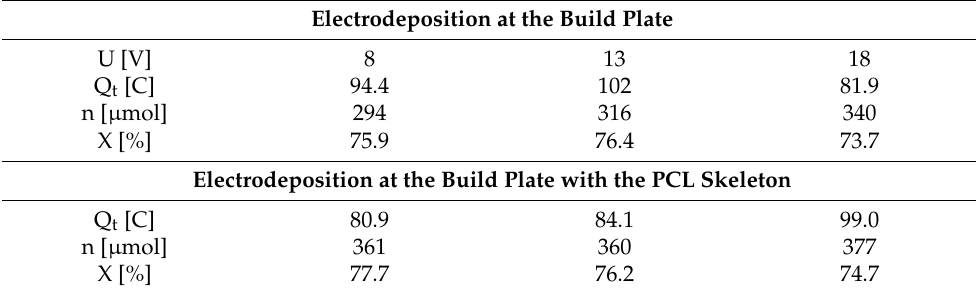
Table 1. Quantitative characteristics of electrodeposition processes at the build plate and at the build plate with the PCL skeleton. Q t —total electric charge, n—amount of evolved gas, and X— water